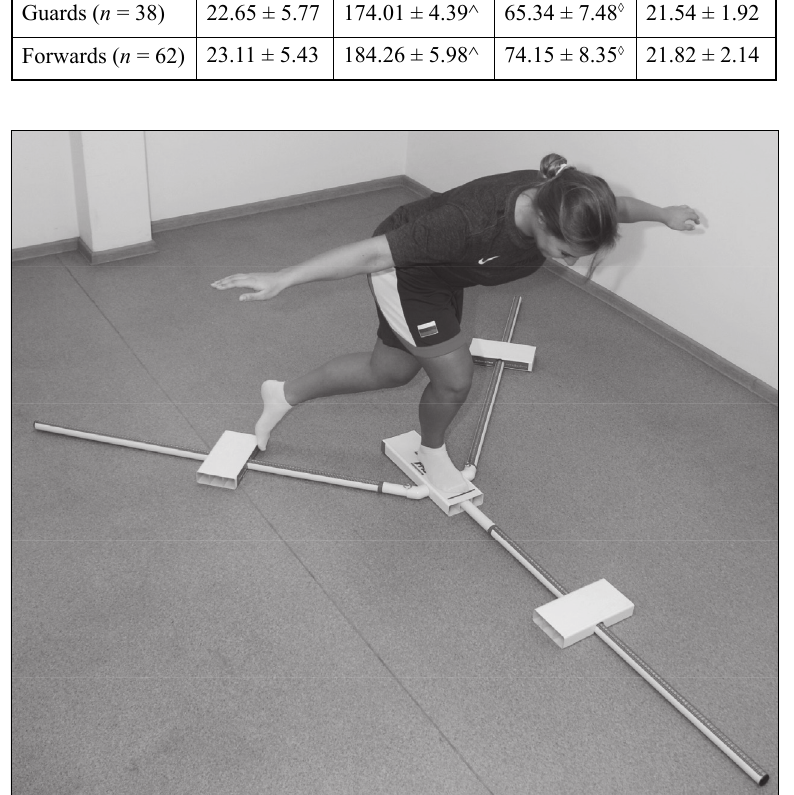
Table 1. Summary of demographic data for guards and forwards